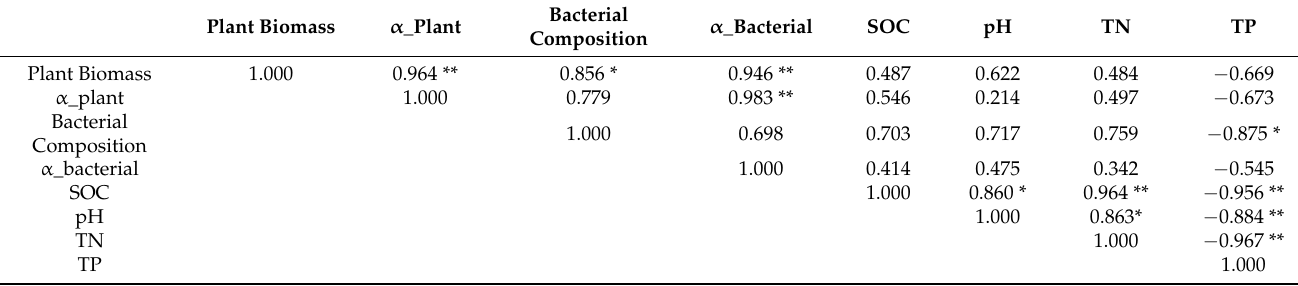
Figure 7. Alpha-diversity of the soil bacterial community in the two forest ecosystems. Alpha diversity indexes of soil bacterial community were significantly responsive to plant biomass and alpha diversity of plant. To validate the relationships among the soil bacterial communities, plant alpha diversity, plant biomass, and edaphic properties, a Mantel test was performed to show the relationships among the variables. The Mantel test showed that there was significant relationship between soil bacterial communities and plant properties, but no significant relationship between soil bacterial communities and edaphic properties or between plant properties and physico–chemical properties. For example, bacterial alpha diversity was significant related to plant biomass and plant alpha diversity ( r values were 0.946 and 0.983, respectively, p < 0.01) (Table 4). Furthermore, the correlation was significant between plant biomass and alpha diversity of plant ( r values were 0.964, p < 0.01). These results could verify our hypothesis that forest with quick growth speed and sparse canopy may has higher biomass productivity and alpha diversity. Table 4. Mantel tests between plant biomass, plant alpha diversities, bacterial composition, bacterial alpha diversity and soil properties, across two forest types.